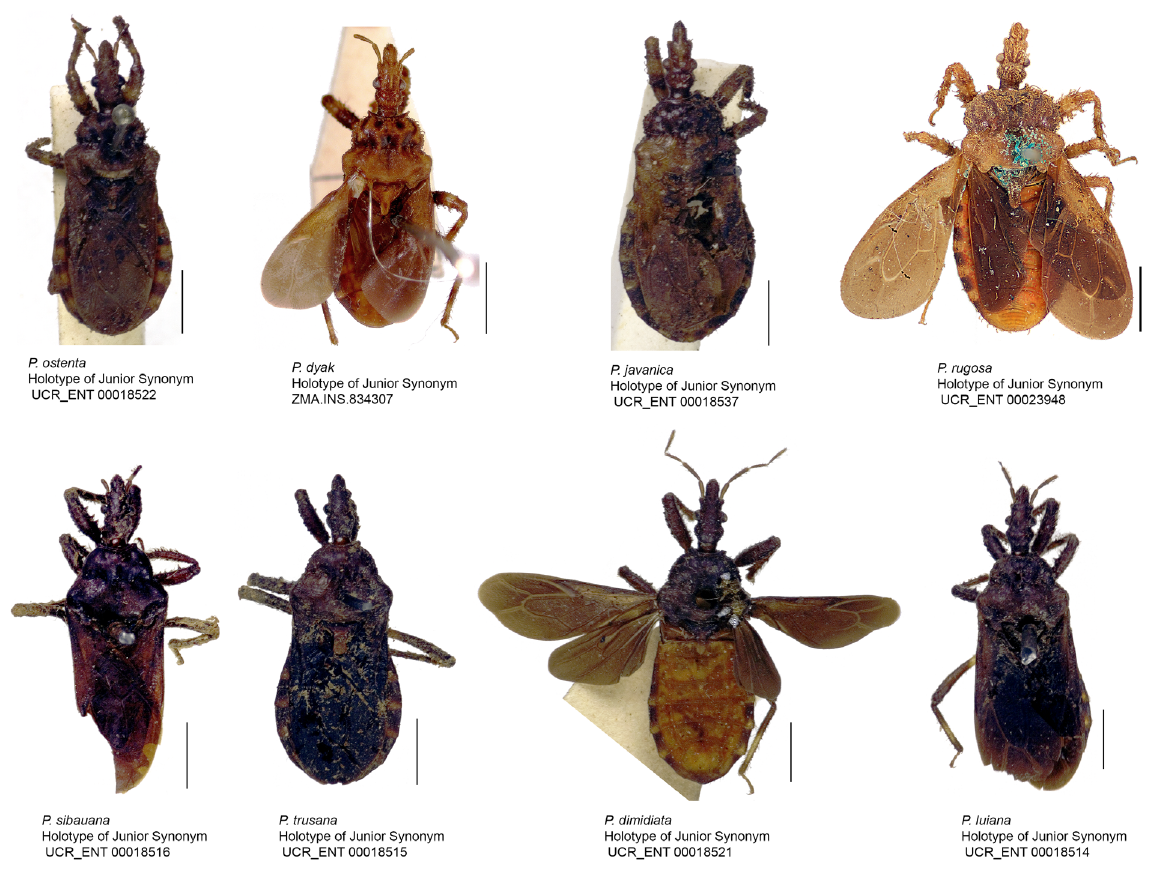
Fig. 7. Dorsal habitus images for junior synonym holotypes of species in Breviphysoderes gen. nov. and Macrophysoderes gen. nov. Scale bars = 2